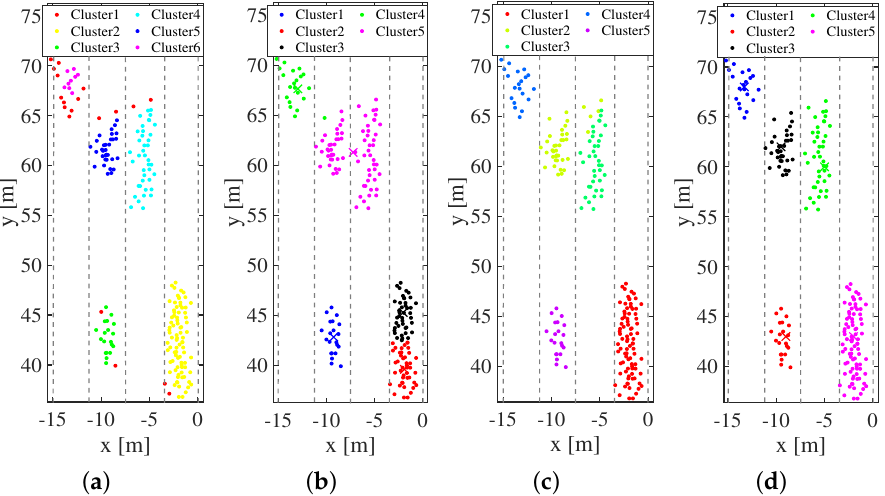
Figure 15. The clustering results of each algorithm: ( a ) DBSCAN; ( b ) FCM; ( c ) K-Means; and ( d ) SDPFC.